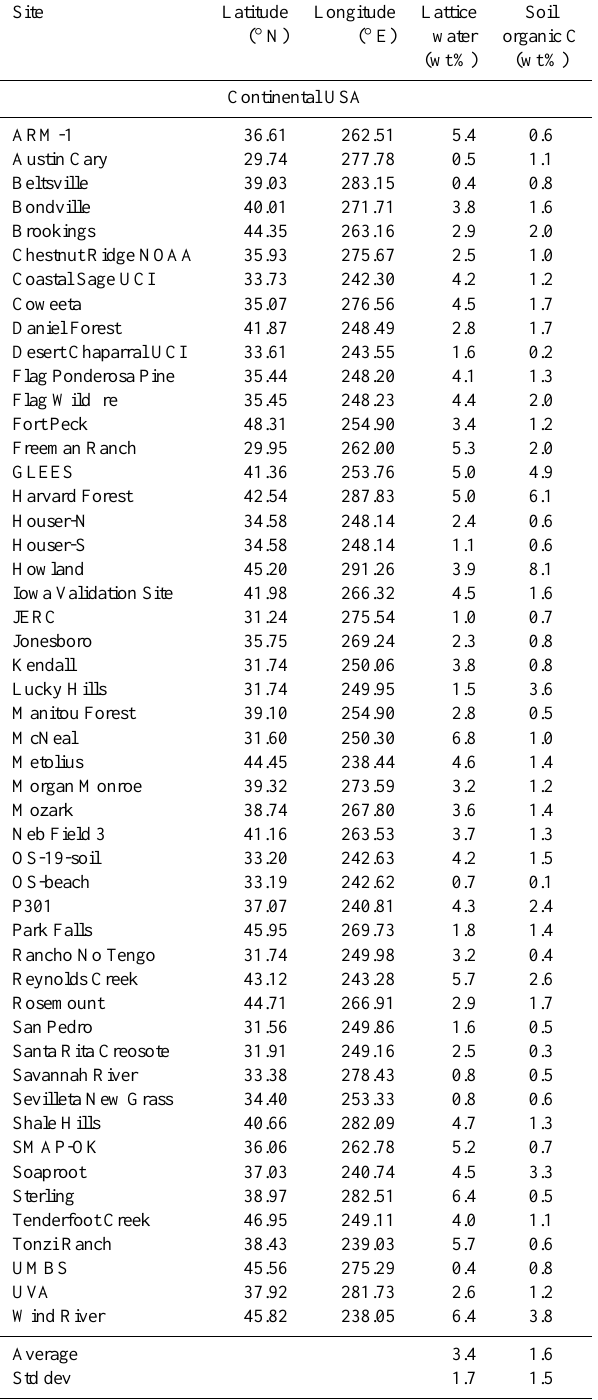
Table 2. Lattice water and organic C in soil samples from the COSMOS sites. Lattice water was measured using the gravity method, and soil organic C was computed from CO 2 measured us- ing coulometry and total C measured using infrared technology. All measurements were done at Actlabs, Ontario,